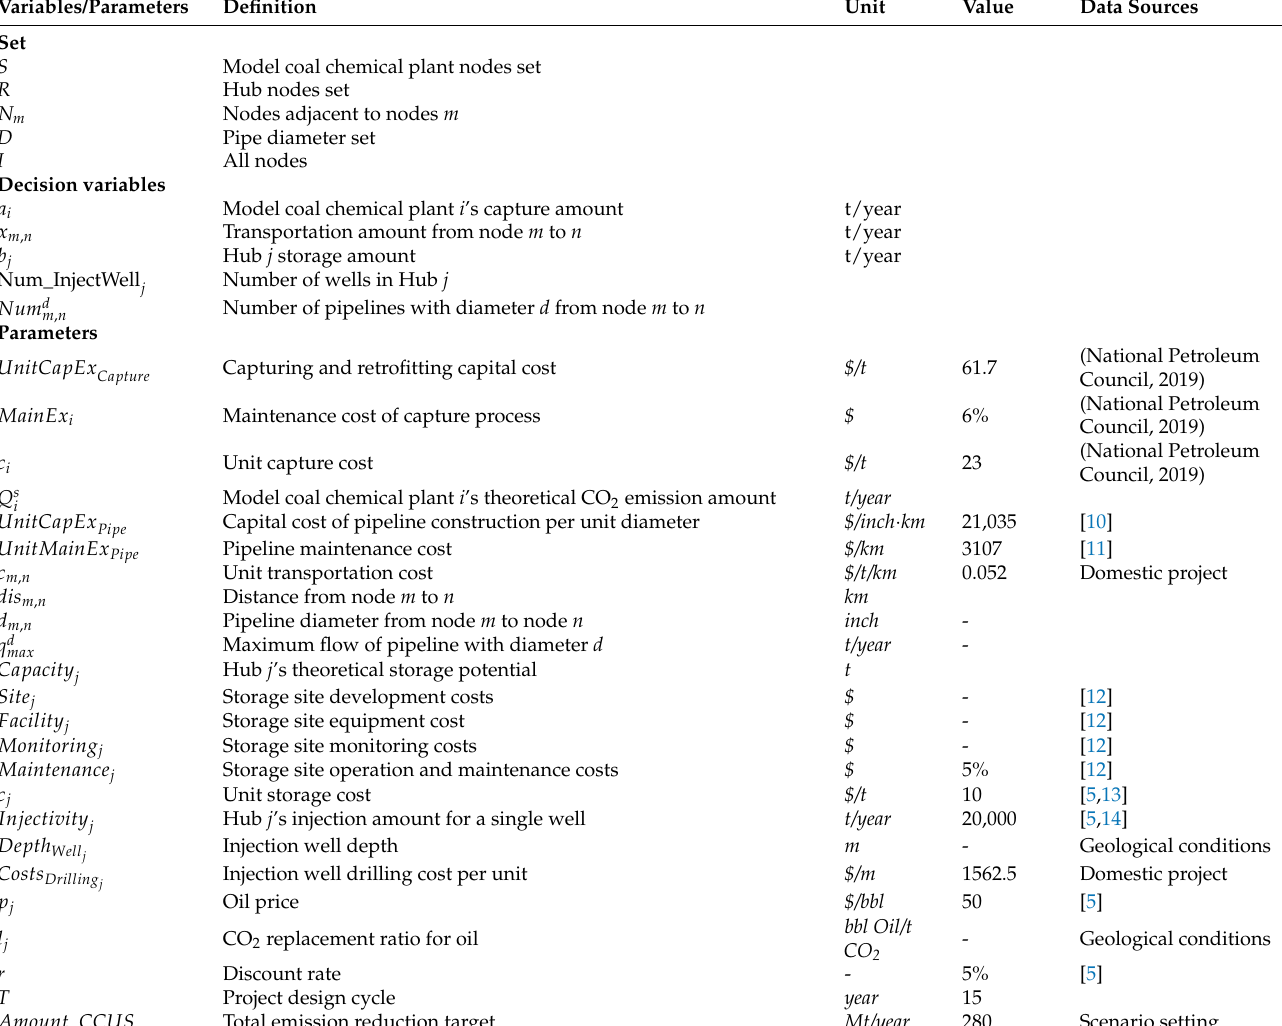
Table 1. Variables and parameters of the pipeline network